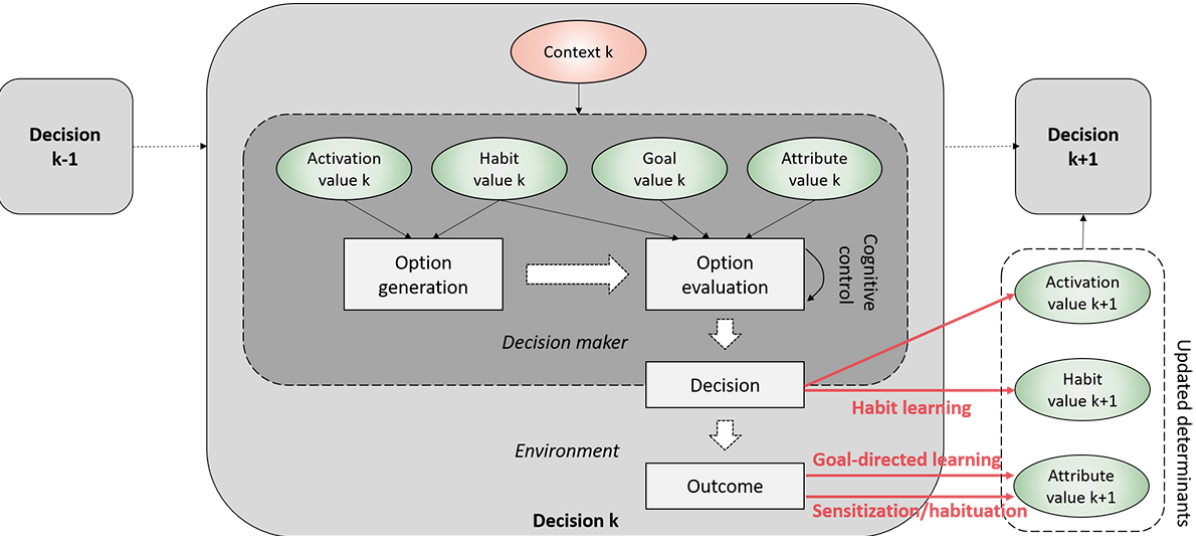
Figure 4. Action-level learning processes added to the decision-making